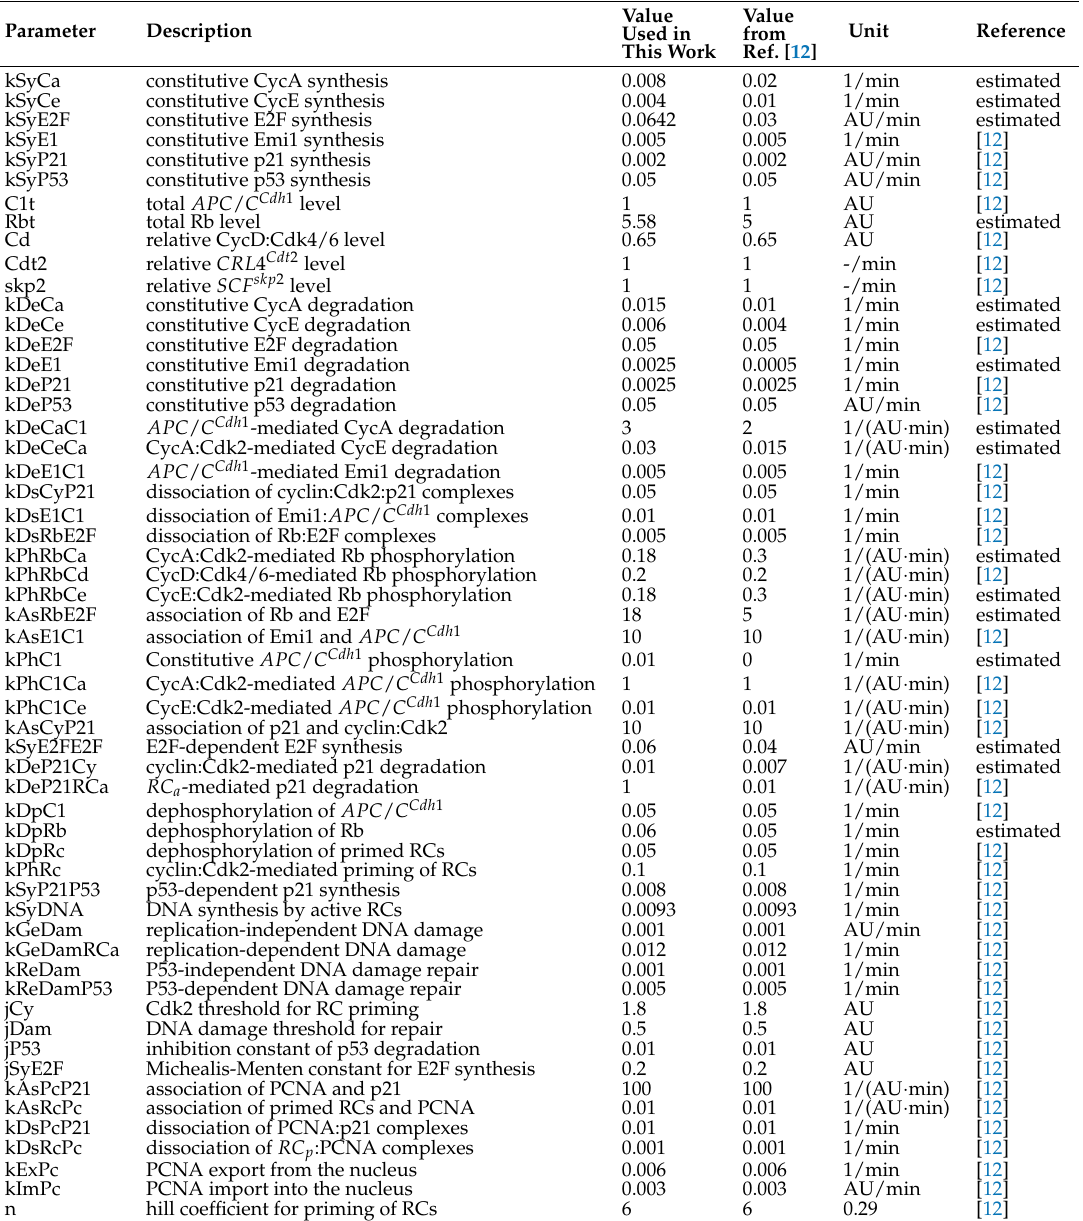
RC pre-replication complexes; RC a active form of replication complexes. RC I inactive form of replication complexes; RC p primed replication